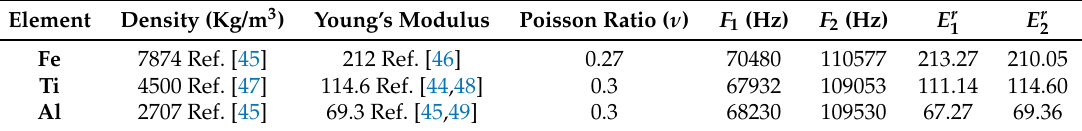
Table 2. Mechanical properties calculated by ab initio (density functional theory), and resonance frequencies of the single crystal metals computed using 3D finite element method ( F 1 , F 2 ). E r are the recovered Young’s moduli (in GPa) using the synthetic resonance frequencies ( F 1 , F 2 ) and the second interaction model (Equation